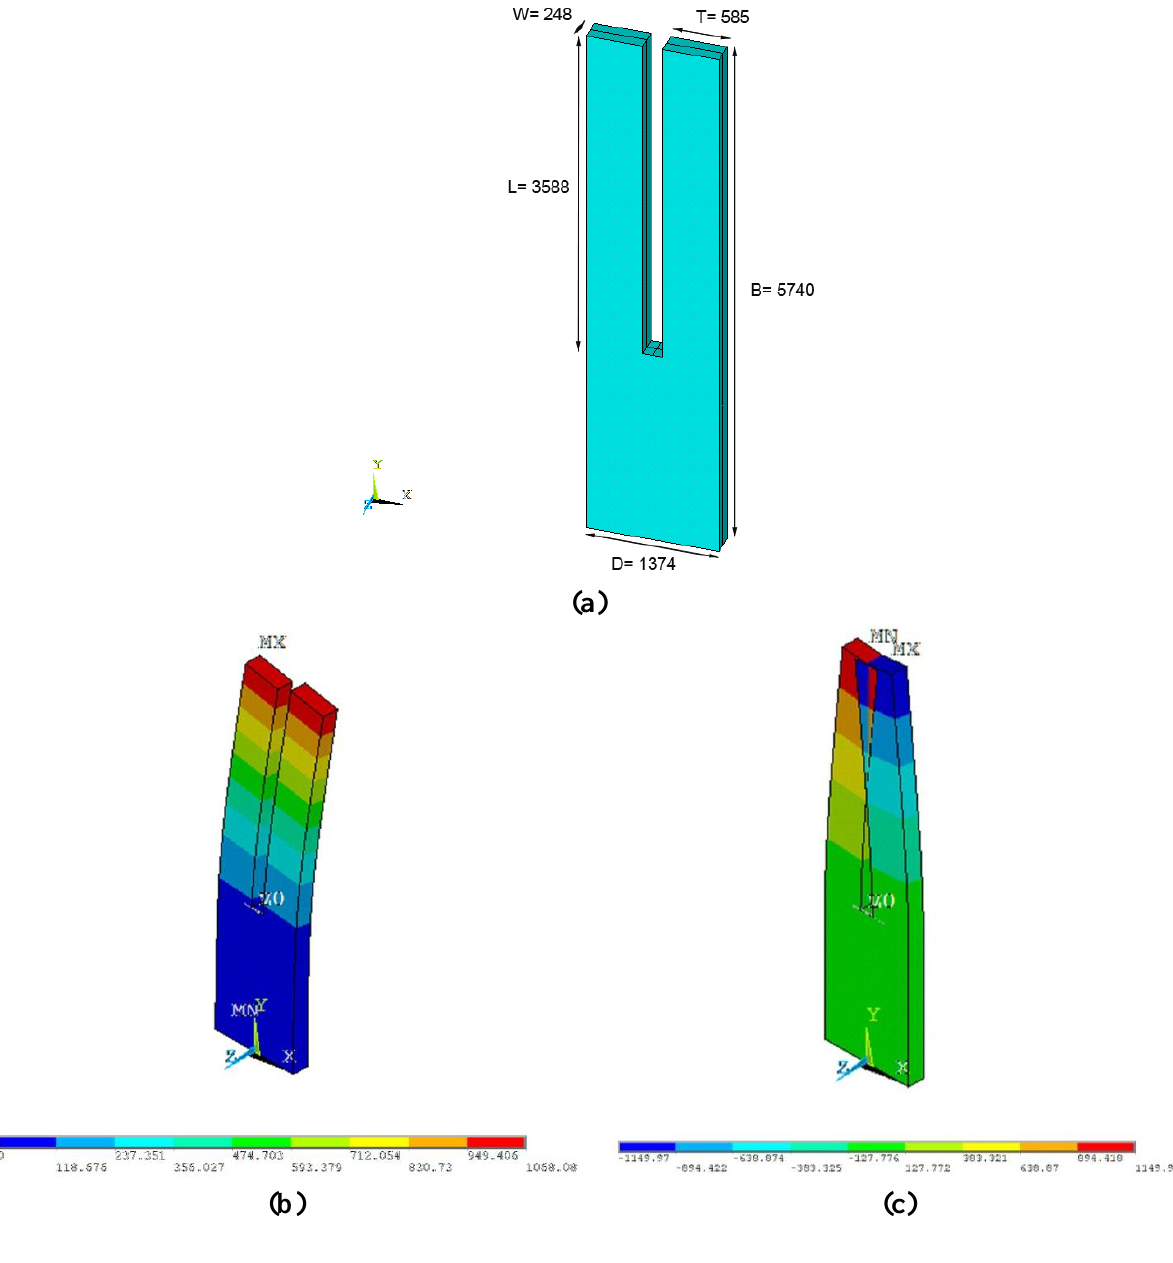
Figure 1. ( a ) Dimensions and geometry of QTF (in  m) ( b and c ) Vibrational modes for in-phase and anti-phase mode of QTF. Bar colors indicate arbitrary units of the displacements along the X